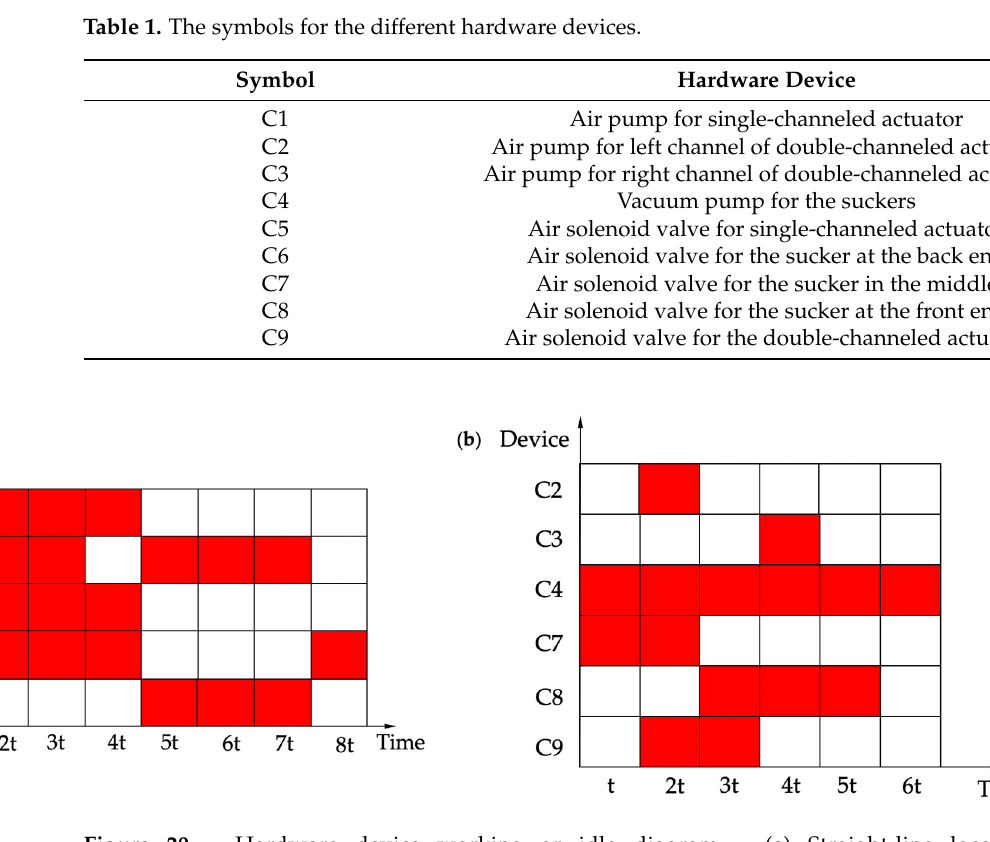
Figure 20. Hardware device working or idle diagram. ( a ) Straight-line locomotion. ( b ) Turning lo- comotion.